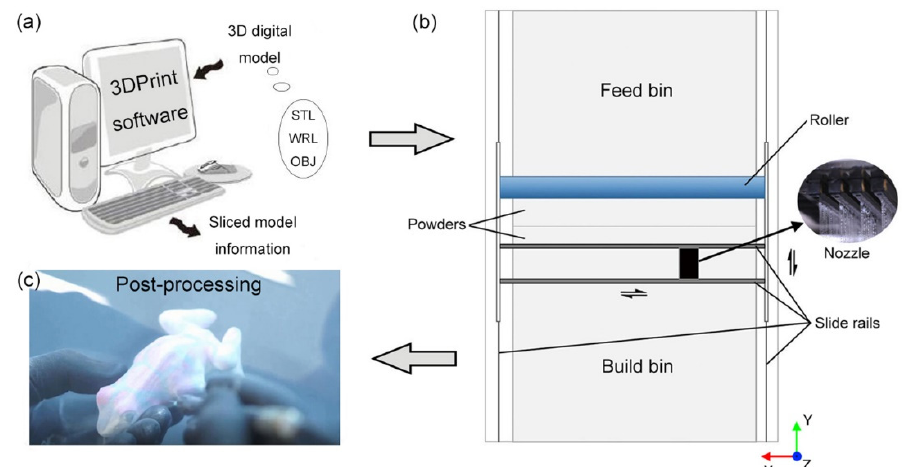
Figure 5. Workflow of powder-based 3DP technique: ( a ) Slicing and transmission of digital model; ( b ) Printer structure chart and coordinate system; ( c ) Post-processing.